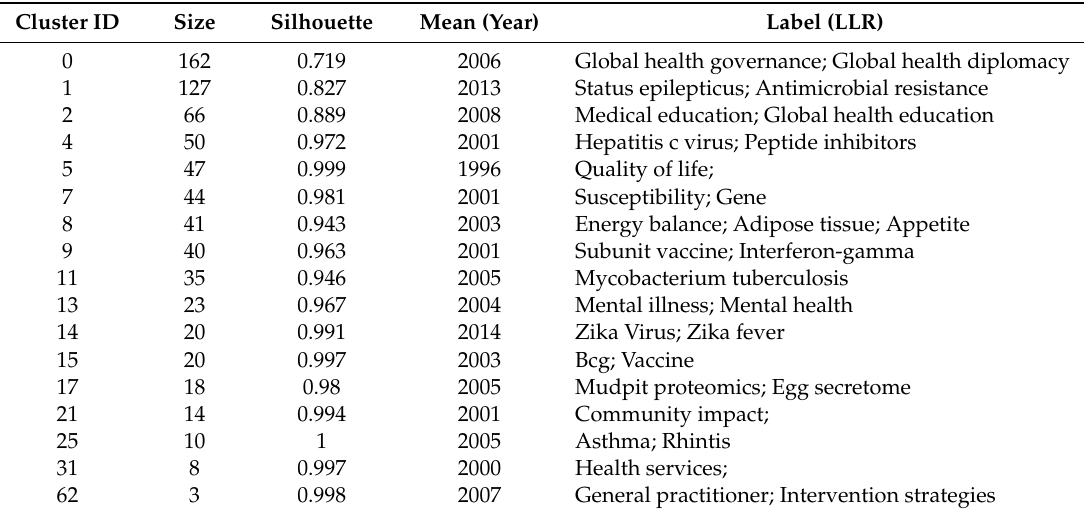
Table 7. Summary table of cluster